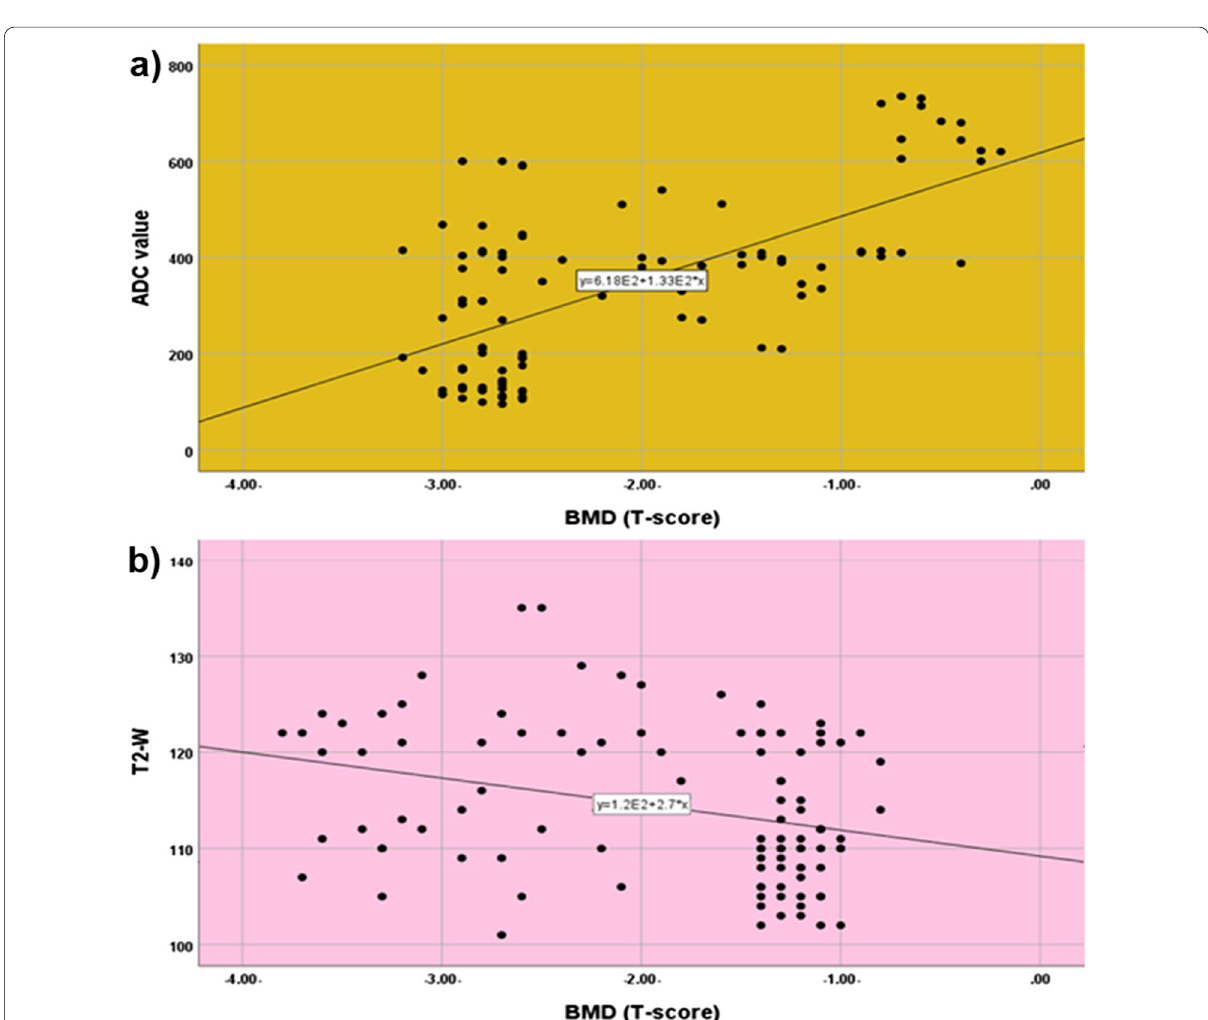
Fig. 3 a Spearman correlation coefficient showed approximately linear relationship between ADC and T‑score values in all groups ( r p 0.001). b The scatter plot observed no significant correlation between the SNR of T 2 ‑w images and T‑score values in all groups ( r = p > 0.05)